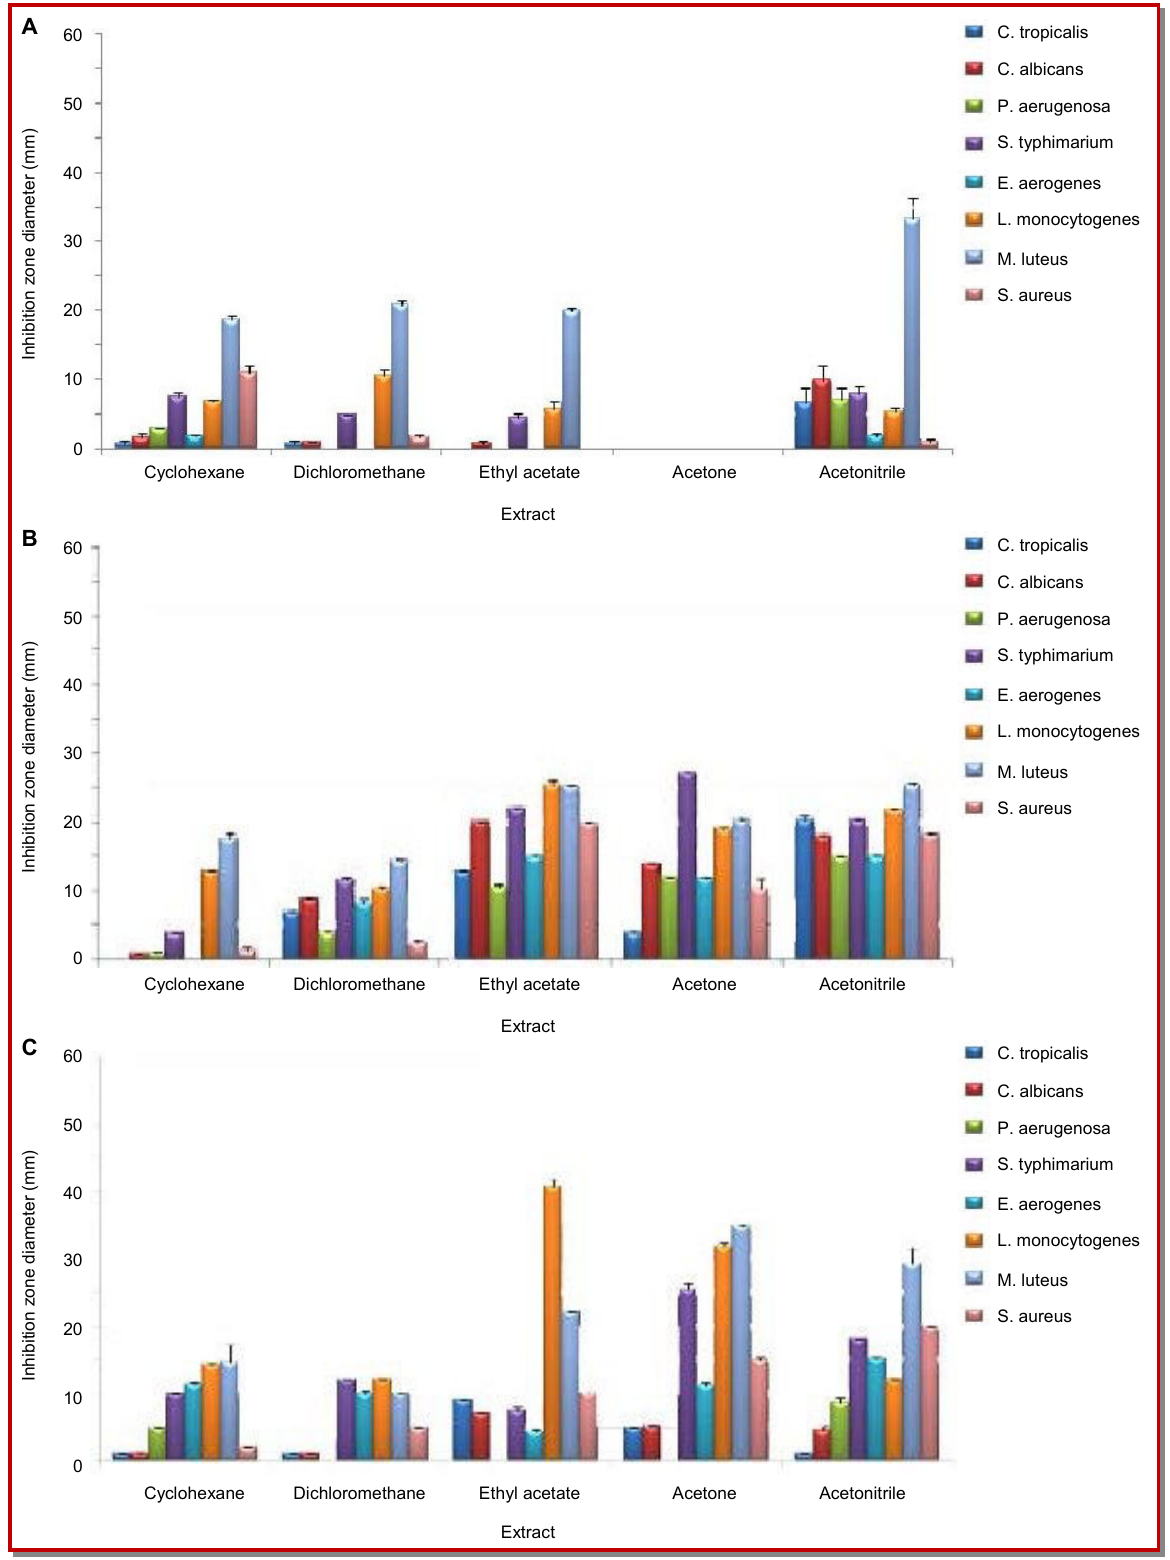
Figure 1: C. arvensis extracts antimicrobial activities by agar diffusion test (inhibition zone in mm). (A) stems extracts activities, (B) leaves extracts activities, (C) flowers extracts